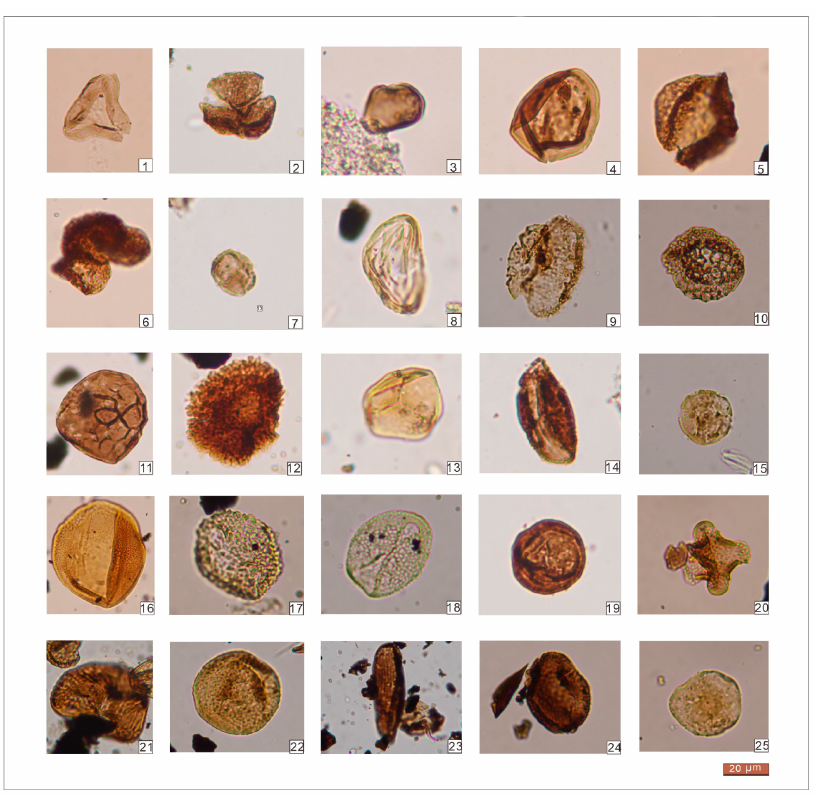
Figure 4. Typical palynomorphs from borehole ZKY2-1. 1 Cyathidites minor . 2 Triphyllopollis trigonos . 3 Laevigatosporites . 4 Punctatisporites . 5 Piceaepollenites . 6 Rugubivesiculites . 7 Retitricolpites . 8 Schizaeoisporites . 9 Integricorpus . 10 Brenneripollis . 11 Triporoletes laevigatus . 12 Gabonisporites . 13 Todisporites minor . 14 Cycadopites . 15 Polyporites . 16 Paleoconiferus . 17 Cerebropollenites . 18 Liliacidites . 19 Classopollis classoides . 20 Aquilapollenites . 21 Cicatricosisporites . 22 Osmundacidites . 23 Jugella . 24 Callistopollenites . 25 Exesipollenites .